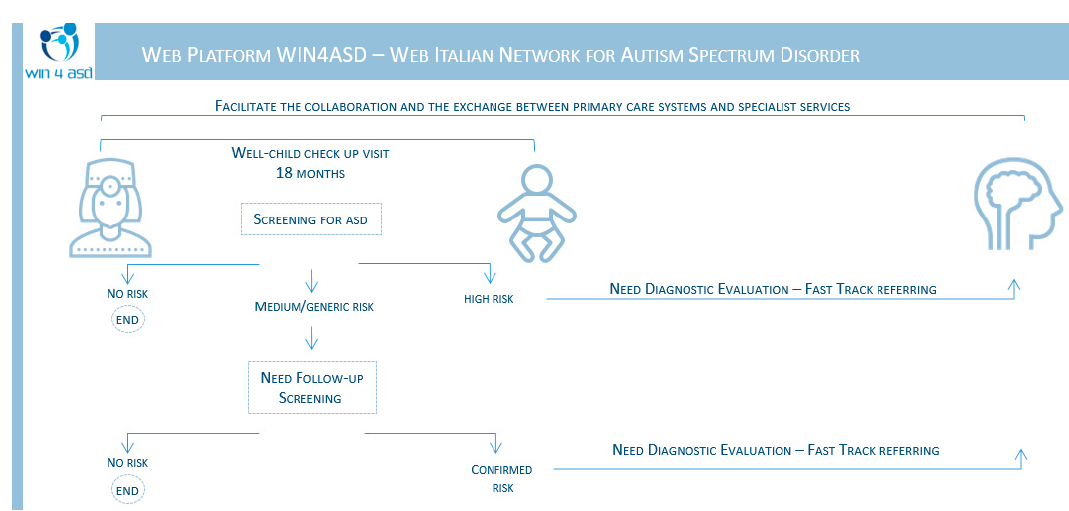
Figure 1. The WIN4ASD web app workflow.